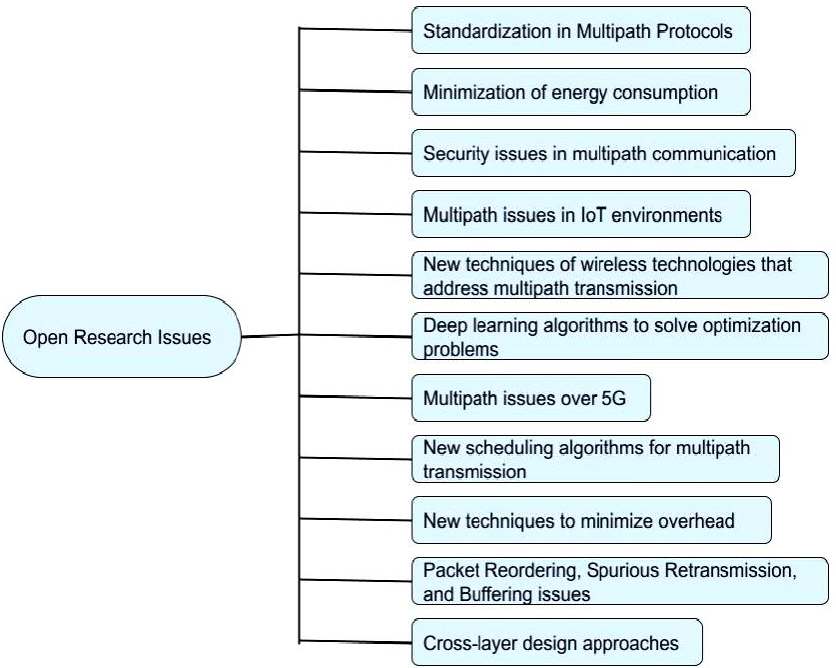
Figure 6. Identified open research